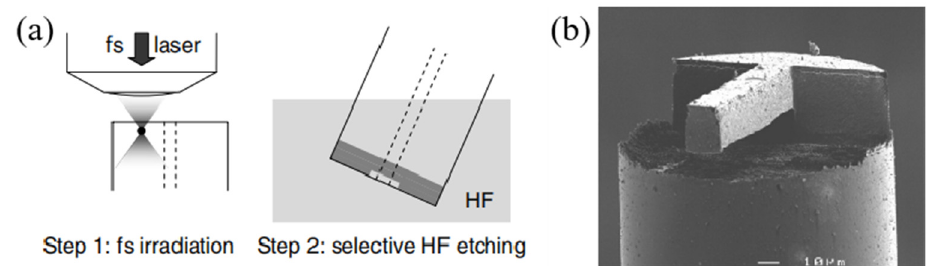
Figure 4. ( a ) Fabrication process of femtosecond-laser-assisted chemical etching. ( b ) SEM image of the fiber-top microcantilever [54].